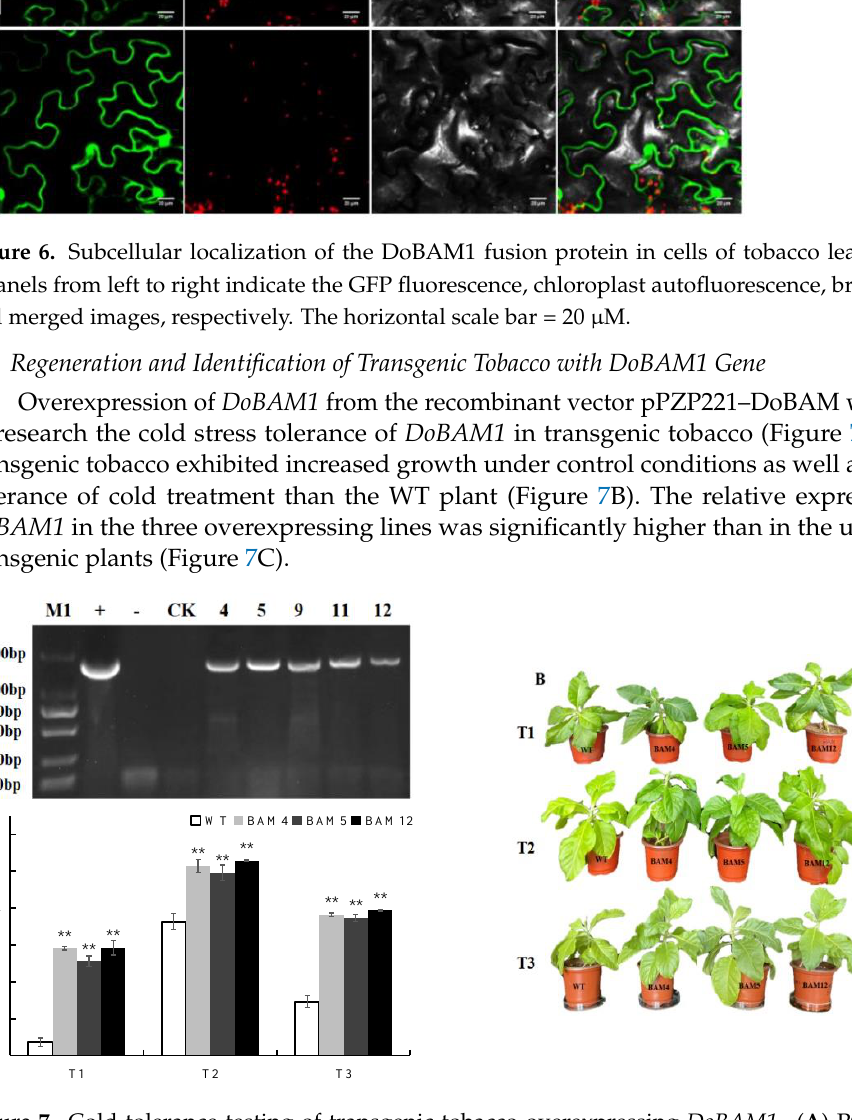
Figure 5. Multiple sequence alignment of DoBAM amino acid family. Blue shading indicates highly conservative substitutions. The two red boxes highlight the catalytic residues Glu-186 and Glu-380.